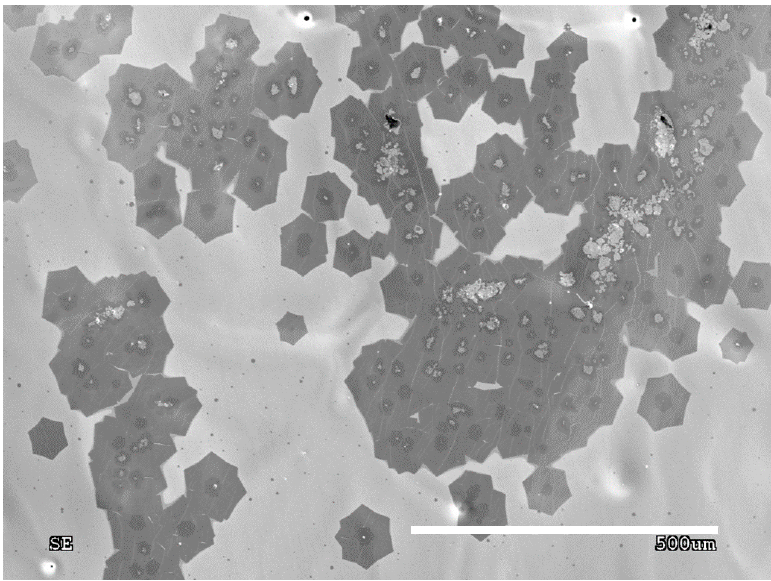
Figure 2. SEM images of the graphene nucleation and its impurities.